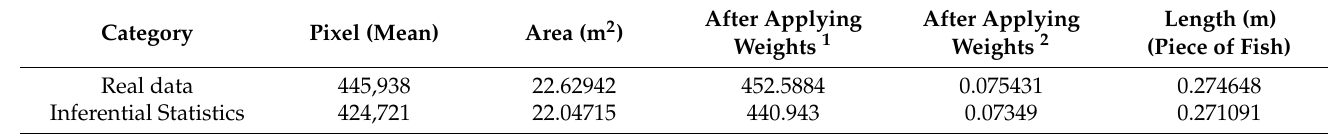
Table 3. Example of calculating estimated size per